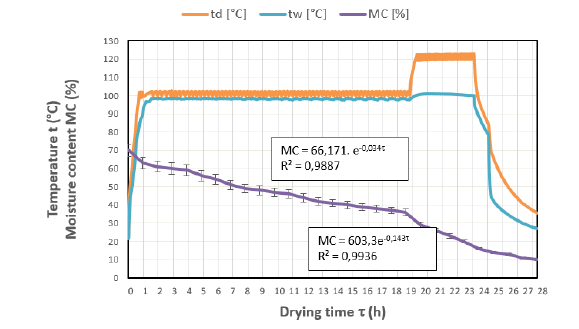
Figure 3: Temperatures and MC in drying process